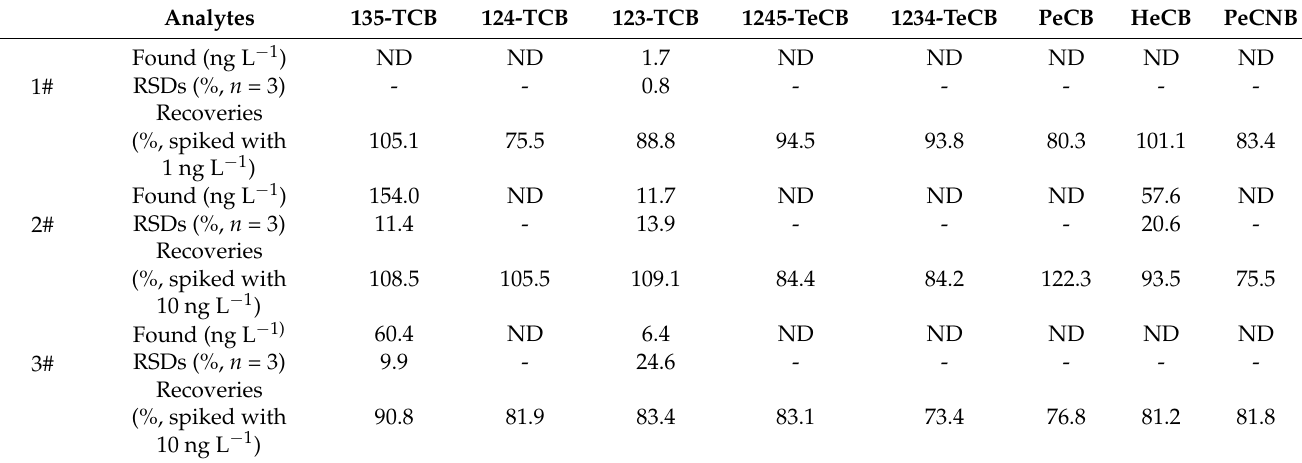
Table 3. Analytical results and recoveries for the determination of CBs in real water samples.